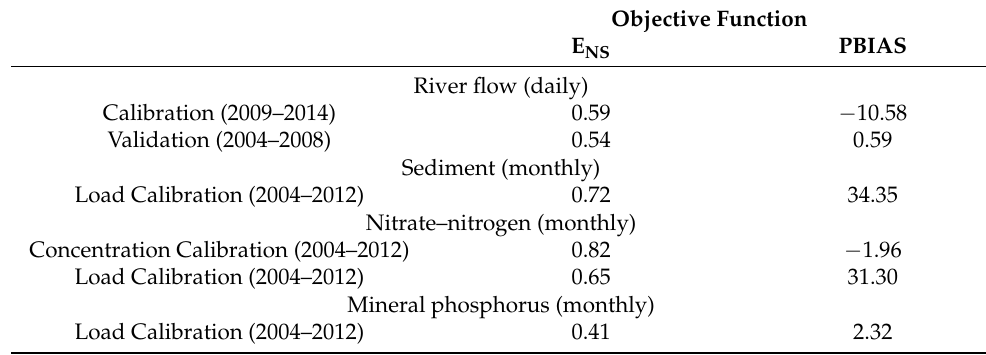
Table 4. Statistical values for the calibration of river flow (m 3 /s) (2004–2014) and sediment concen- tration (mg/L), nitrate–nitrogen concentration (mg/L) and load (kg/day) and mineral phosphorus load in the Sutla River (2004–2012)